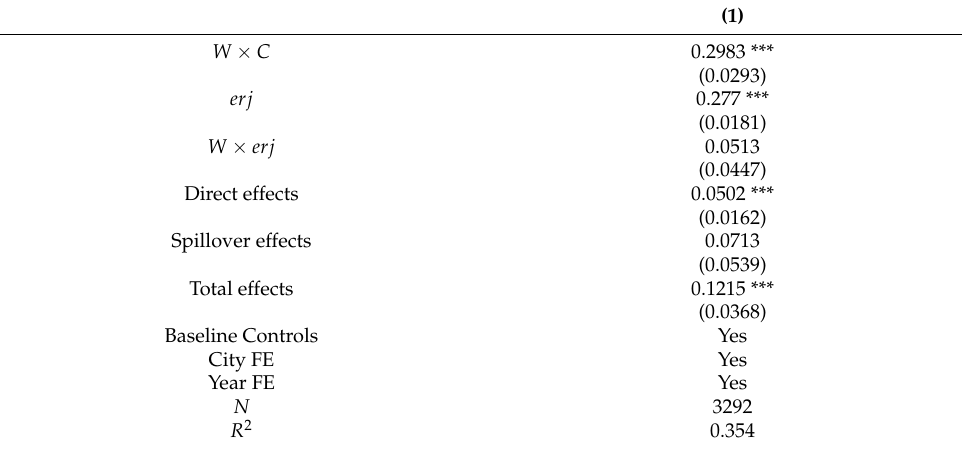
Table 9. Spatial regression model estimates for CO 2